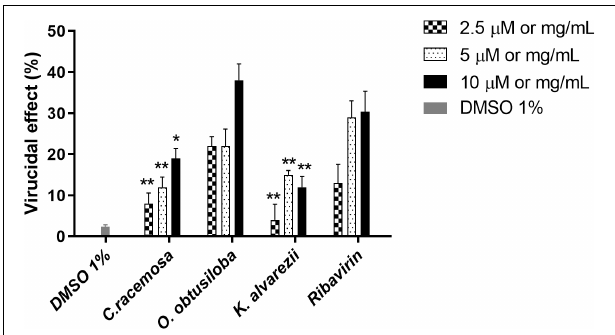
FIGURE 5 | Effect of C. racemosa, O. obtusiloba and K. alvarezii crude extracts on infectivity of CHIKV. To assess potential virucidal activity, we incubated stock CHIKV [CHIKV (106 PFU/mL) at MOI of 0.1] directly with each compound separately at different concentrations for 1 h or with vehicle/DMEM, after which we determined virus titers by standard plaque assays in Vero cells. Experiments were performed independently in triplicate with duplicate plate assays. Error bars indicate the standard deviation and experiments were performed in triplicate. ∗ p < 0.05; ∗∗ p < 0.01 in Dunnett test vs. control (Ribavirin). DMSO used as solvent remained at the final concentration of 0.01%, showing no virucidal activity on